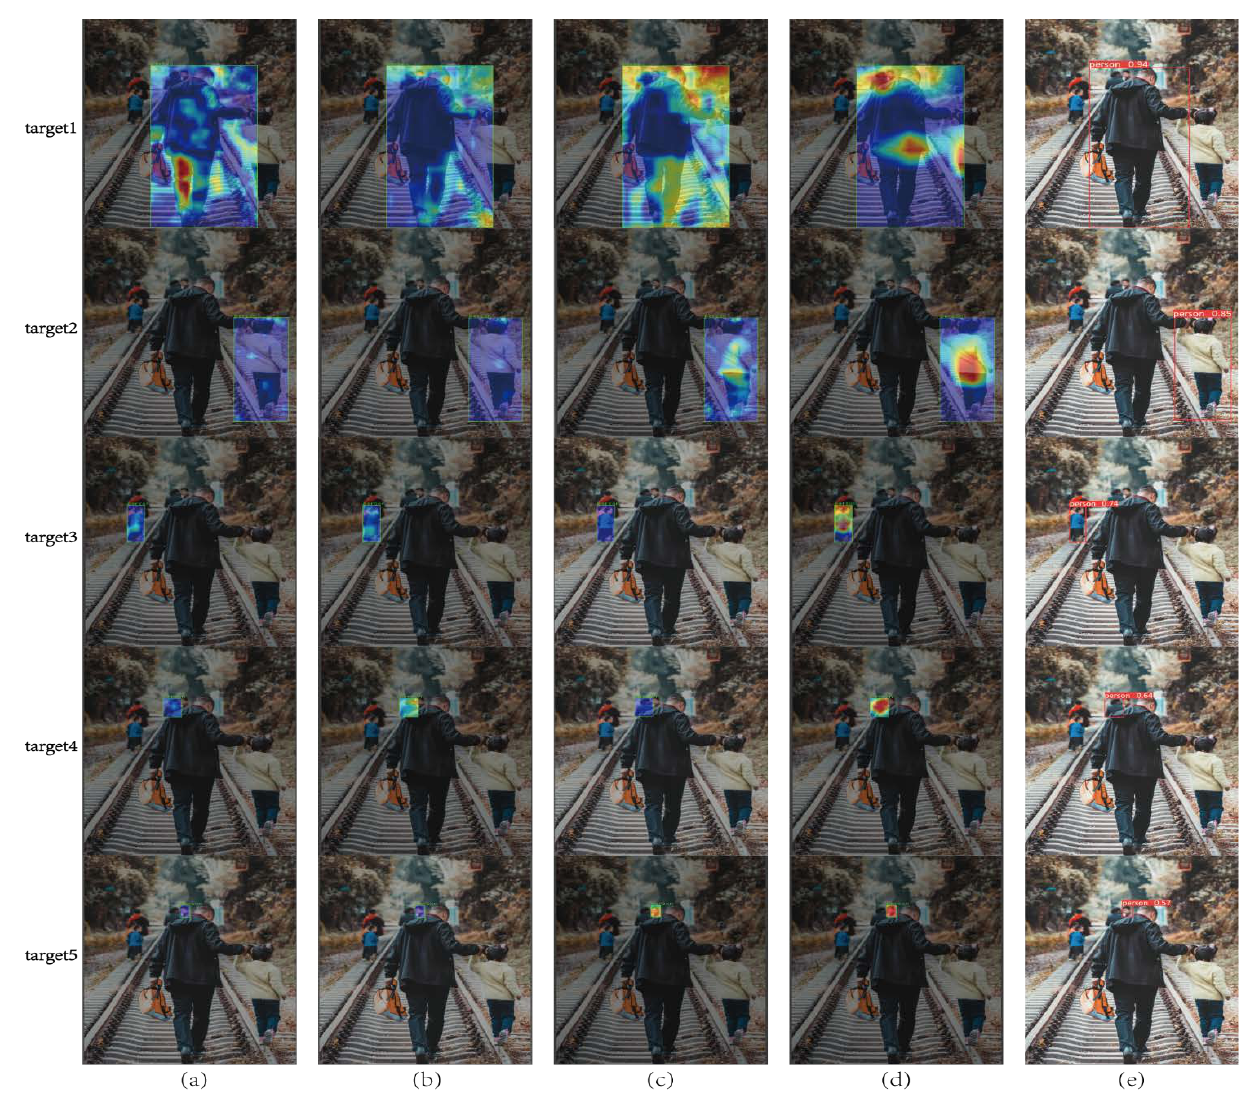
Figure 22. Visualization of heatmaps. ( a ) stage1_C3 heatmaps; ( b ) stage6_C3 heatmaps; ( c ) AC_FPN heatmaps; ( d ) output heatmaps; ( e ) detection results.